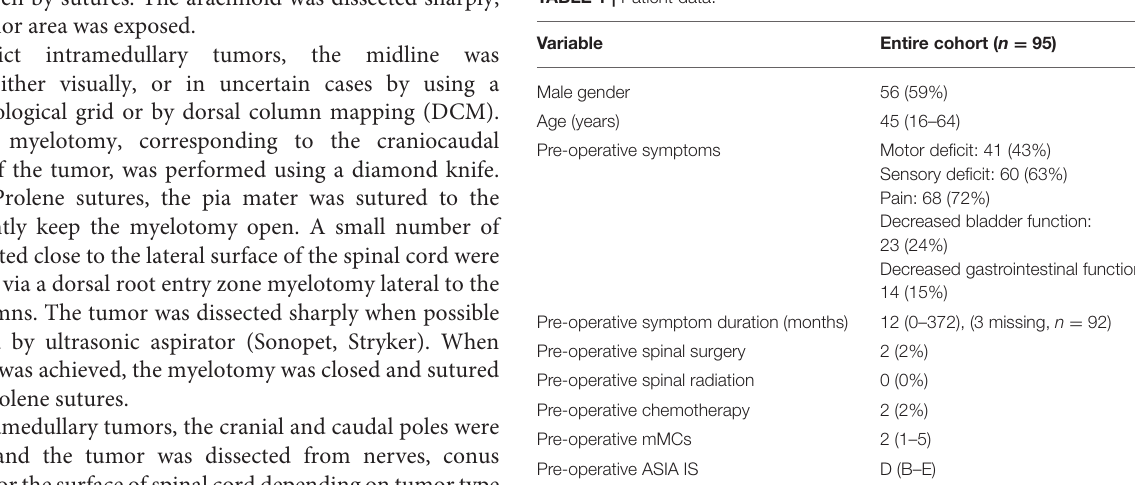
TABLE 1 | Patient